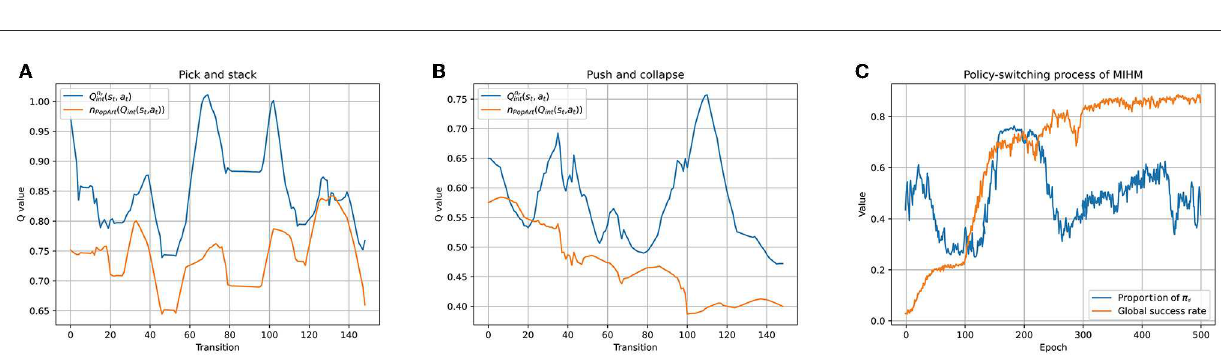
FIGURE6 Execution details of hybrid policy mechanism. (A, B) Show comparisons between two normalization approaches for constructing the combined Q-function. Compared with the outputs of Q n r int ( s t , a t ) , the outputs of n PopArt ( Q int ( s t , a t ) ) are smoother and closer to zero. (C) Shows the policy-switching process when training the RL agent by MIHM. The proportion of π d fluctuates around 0.5 and the agent can dynamically switch between exploration and exploitation as